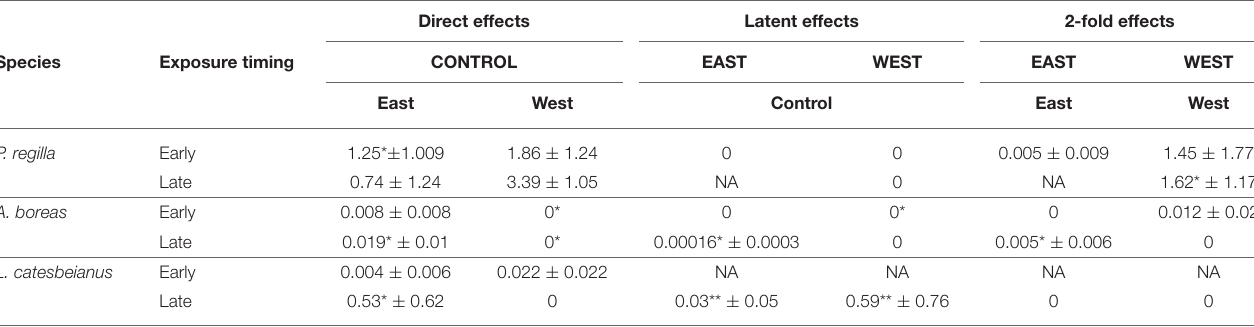
A star * indicates significant effects in the odds of mortality of larvae. NA indicates treatments without samples due to mortality in the pre-hatching exposure part.